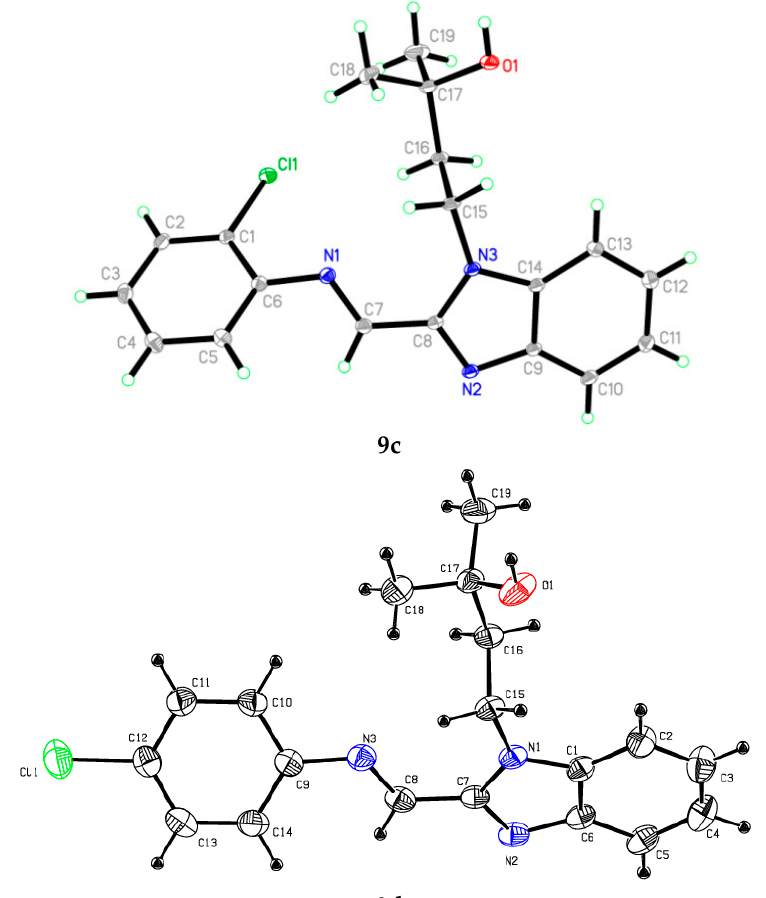
Figure 2. ORTEP diagram of 9c and 9d .